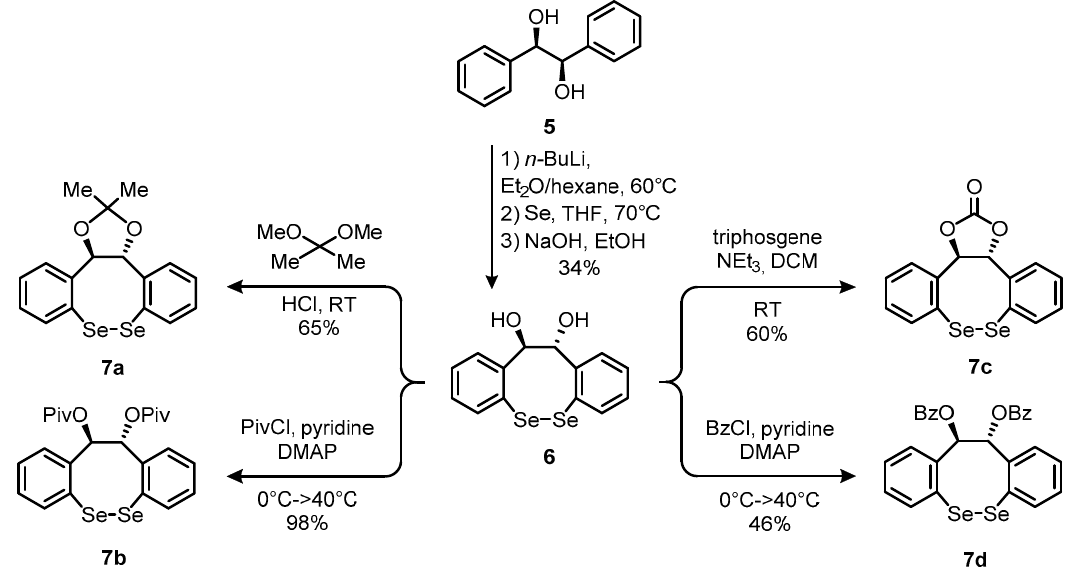
Table 1. Solvent and catalyst screening for the enantioselective